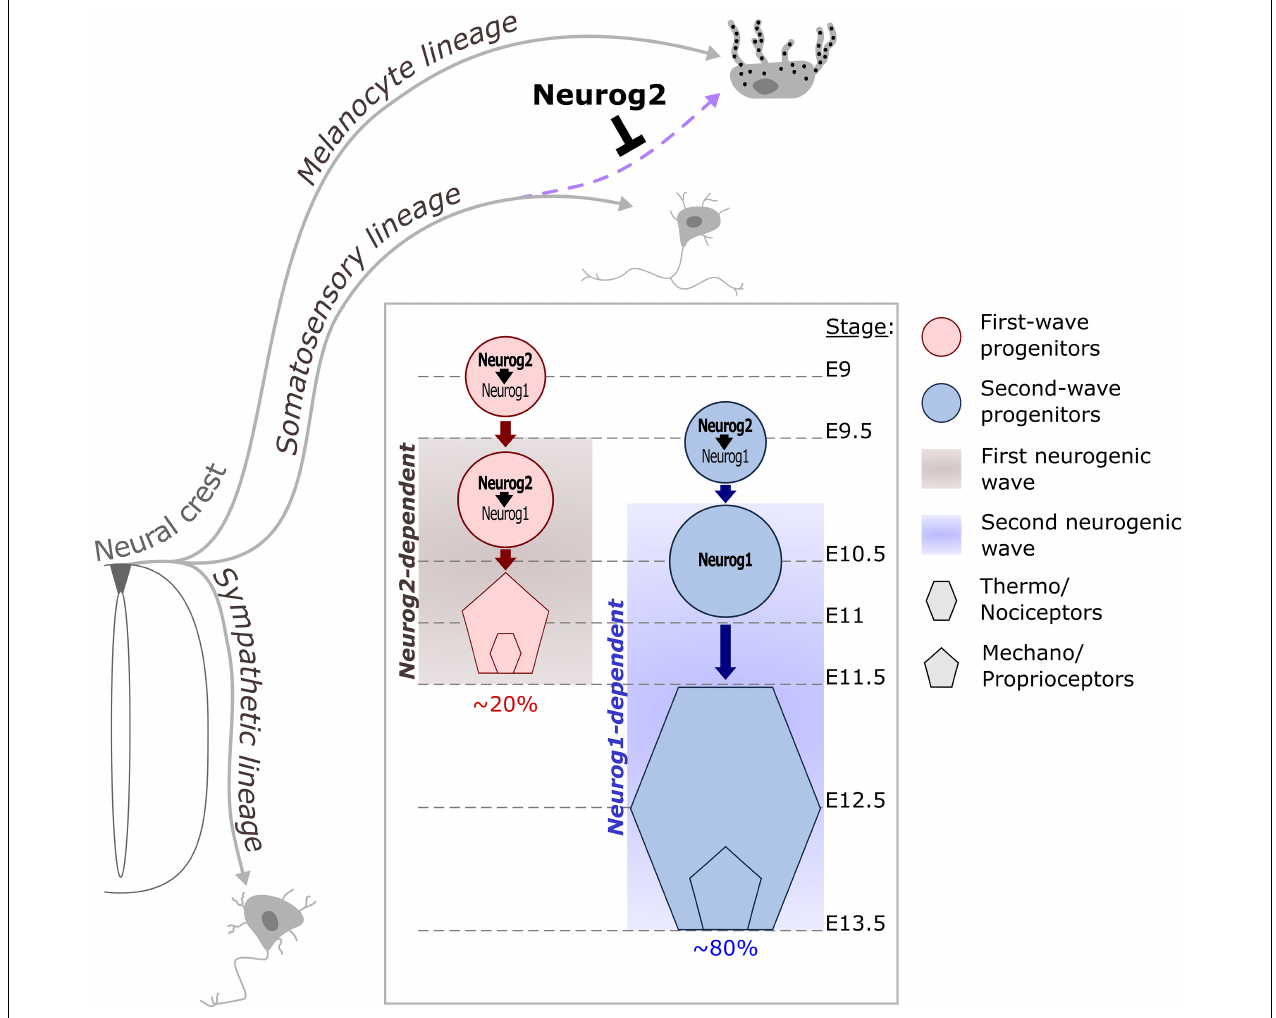
FIGURE 5 | Contribution of Neurog proneural factors to DRG somatosensory neurogenesis in mouse. NCC delaminate from the dorsal part of the neural tube and differentiate into distinct lineages. Early expression of Neurog2 in migrating NCC prevents melanocyte fate in a subpopulation of progenitors dedicated to the somatosensory lineage (purple dashed arrow). Somatosensory neurons in DRG are generated during two overlapping waves of neurogenesis. The first wave occurs between E9.5 and E11.5 and is Neurog2-dependent. This wave contributes to ∼ 20% of the DRG neuronal population and mostly generates mechano/proprioceptive neurons as well as a subset of nociceptors which are the large diameter nociceptors. During the second wave, Neurog2 is not sufficient to drive the differentiation of progenitors but is required to ensure the on-time onset of Neurog1 , which depends on Neurog2 for its expression between E9.5